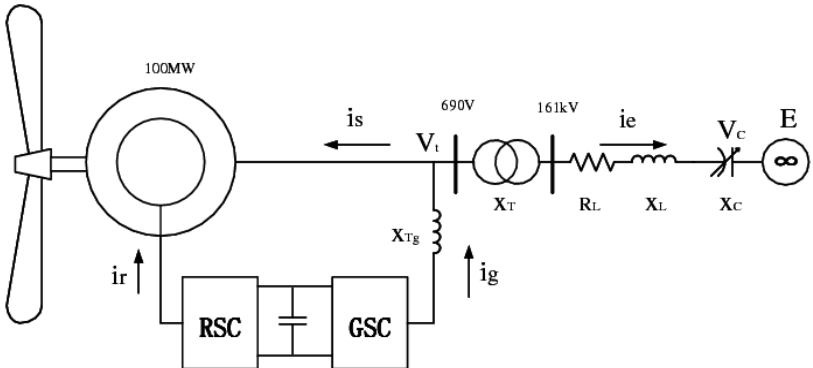
Figure 1. The system structure.